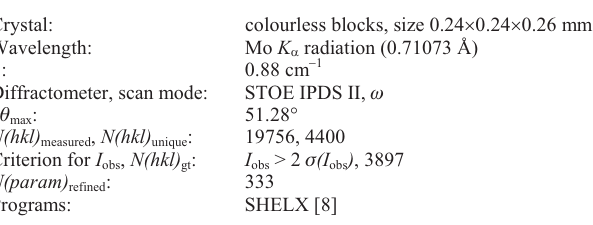
Table 1. Data collection and handling.